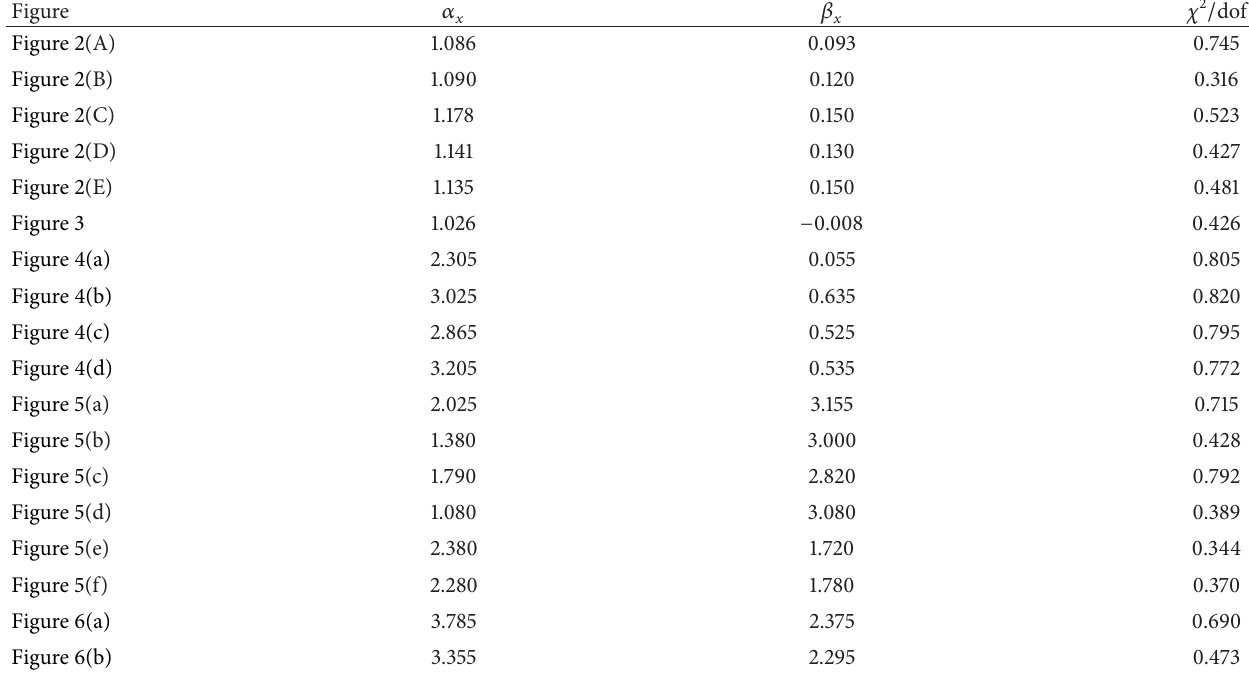
Table 1: Values of 𝛼 𝑥 and 𝛽 𝑥 of the calculations in Figures